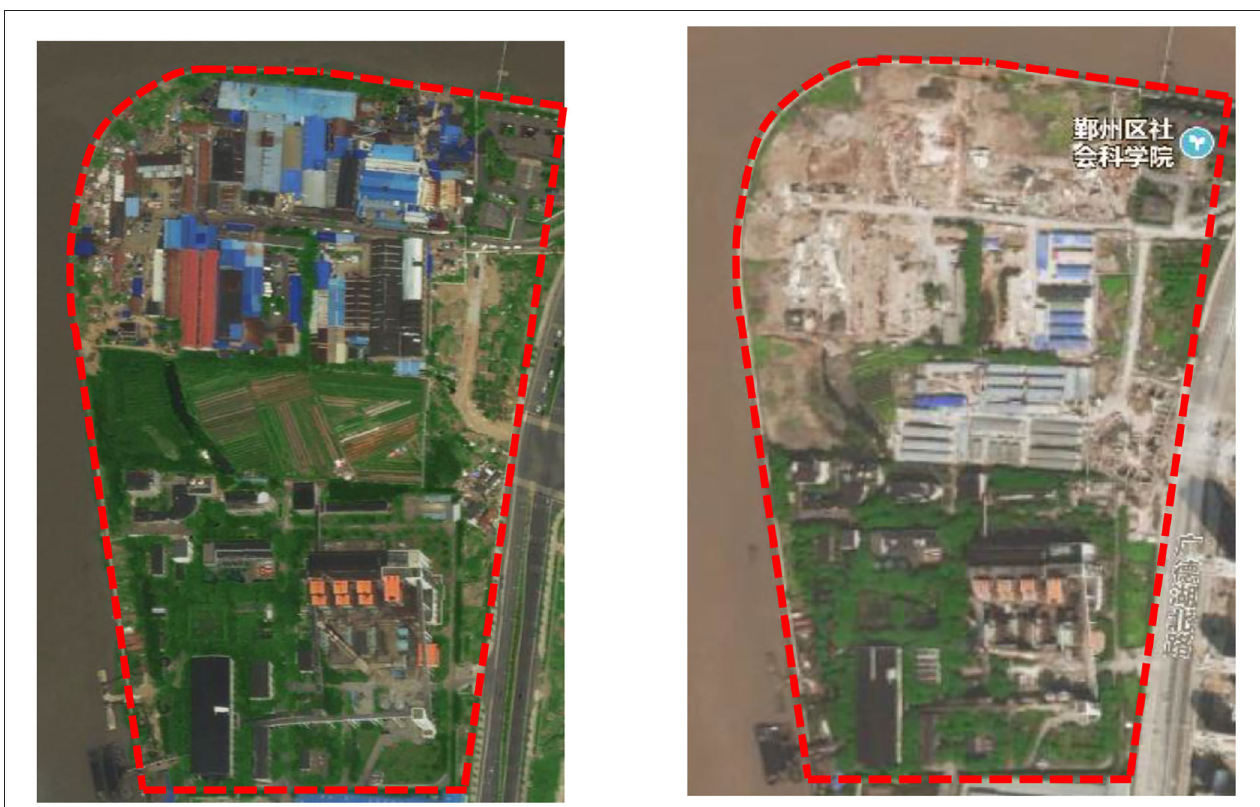
FIGURE 2 | Plan of site area through Baidu Map (left: status in 2013 prior to redevelopment phase; right: status in 2017, which is now under construction as of 2021) (source: authors’ own, extracted from Baidu local maps).